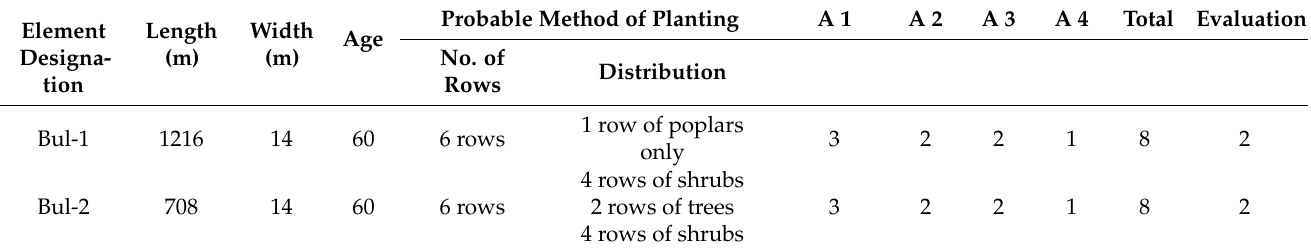
Table 9. Example of the evaluation of two windbreaks in study locality